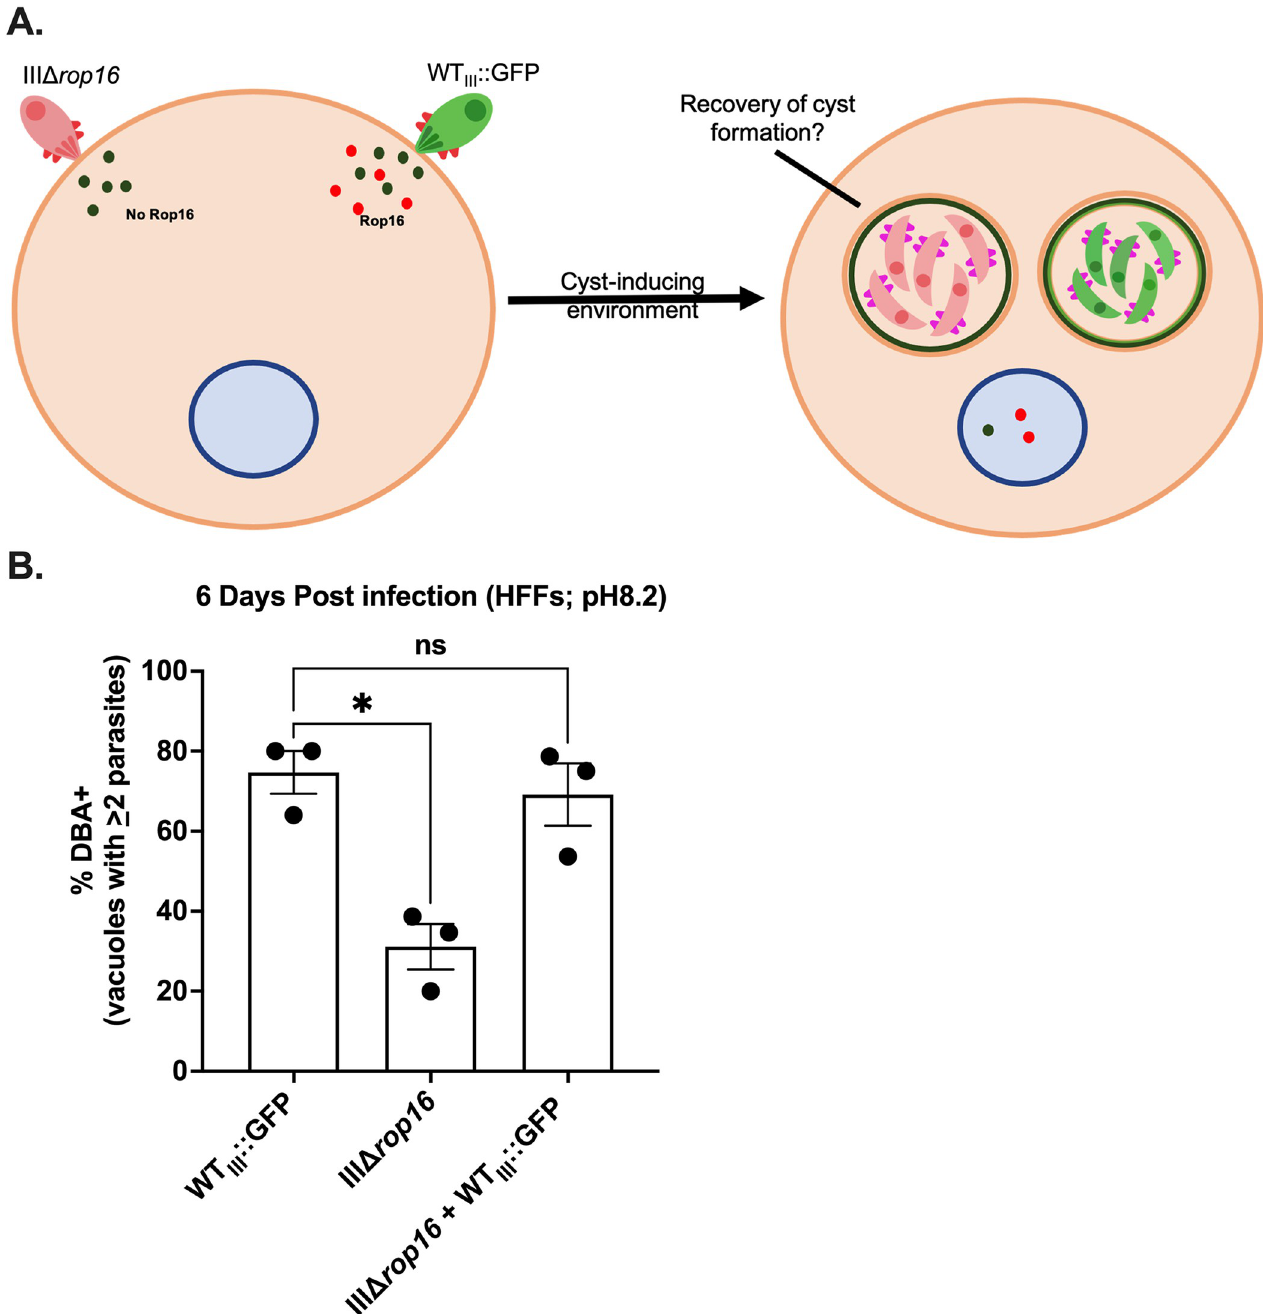
Fig 2. Co-infection of III Δ rop16 with WT parasites restores encystment. (A) Schematic of co-infection experiment. WT III :GFP parasites are type III (CEP) parasites that express GFP. The dark circles represent non-ROP16 rhoptry protein secretion. The red circles represent ROP16 secretion by the WT III ::GFP parasites. (B) Quantification of encystment at 6 dpi in alkaline stress model of encystment. Bars, mean ± SEM. Black dots = Average % cyst for 1 experiment. N = 3 replicates/experiment, 3 experiments total. * p � 0.05, ns = not significant, one-way ANOVA, Dunnett’s multiple comparisons test compared to WT III